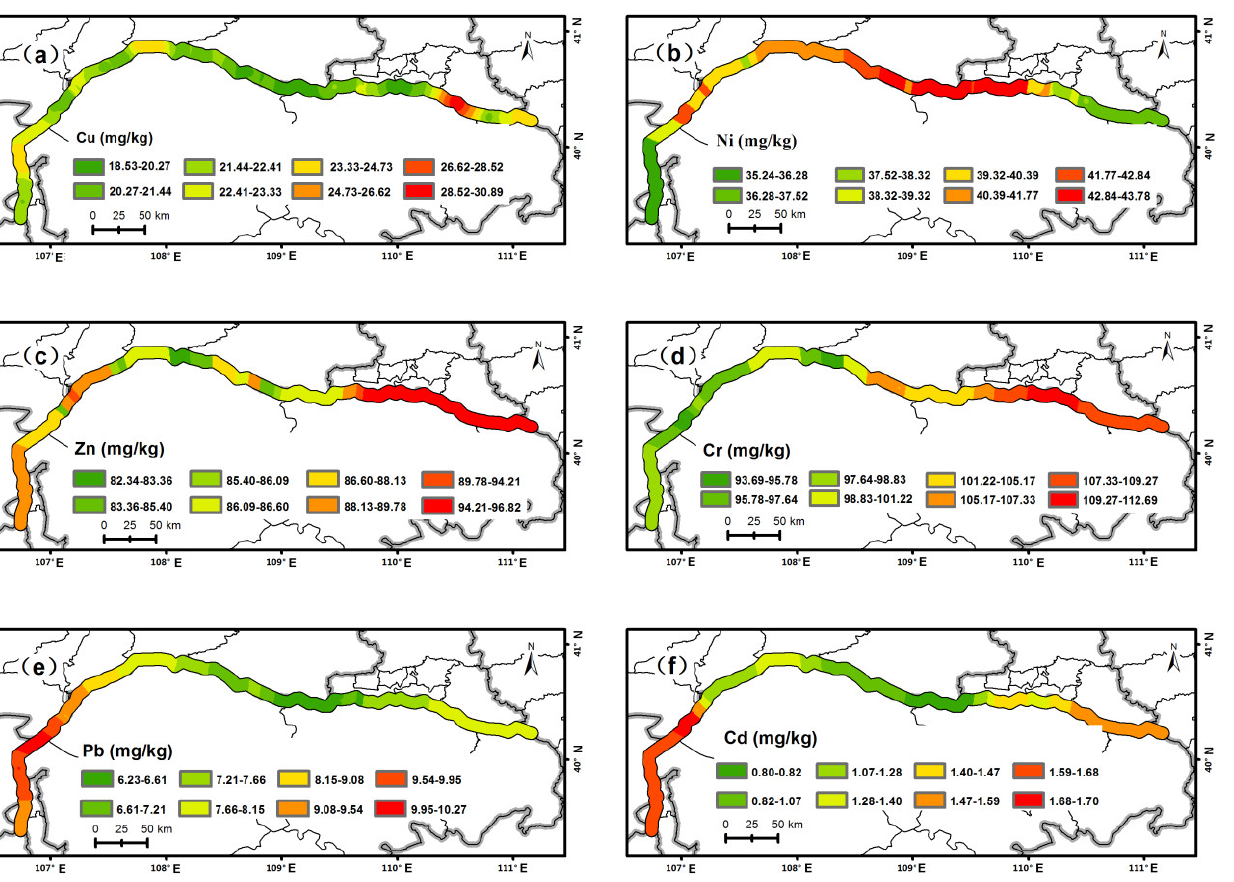
Figure 3. Spatial Distribution of sediment heavy metal ( a ) Cu, ( b ) Ni, ( c ) Zn, ( d ) Cr, ( e ) Pb, and ( f ) Cd in Inner Mongolia section of the Yellow River.